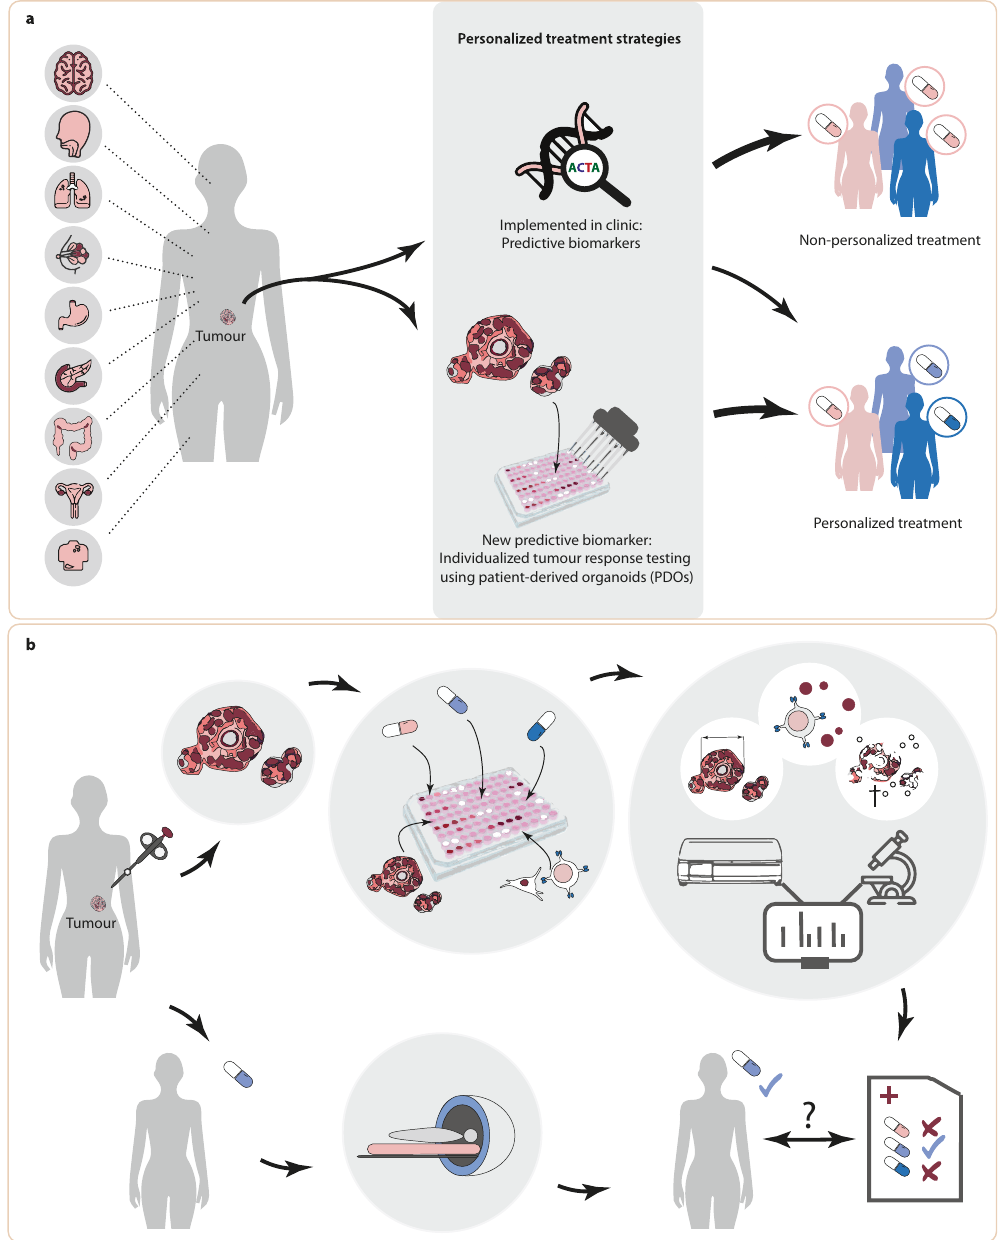
Fig. 1 PDO-based individualized tumour response testing as a predictive biomarker. a Illustrates the tumour types for which patient- derived organoids (PDOs) have been tested for clinical validity (listed in full in Table 1). Personalized treatment strategies currently implemented in oncology treatment largely comprise of genomic biomarkers. However, this only results in a personalized treatment strategy for a minority of patients. Individualized tumour response testing using PDOs is a new biomarker which may be used in personalized treatment and increases access to personalized treatment. b For individualized tumour response testing, tissue from a patient ’ s tumour is obtained to culture organoids, perform drug screens and various read-outs can be obtained to de fi ne PDO drug screen response (including organoid size, viability and co-culture cytokine measurements). A predictive biomarker test is developed using the PDO drug screen results and clinical response seen in assays and/or engraftment of organoids in mice (summarized in compositions and culturing techniques differ. Serum-free growth Supplementary Table 2). In four studies, genomic analysis factors are increasingly becoming available, which allows estab- included criteria for which PDOs could be excluded from analysis due to poor quality 14,21 – 23 . Of note, in several studies quality used serum-based media 17 – 19 , while one study did not specify control was performed on a subset of PDOs, not the whole cohort. A recent protocol for establishing PDOs for drug which medium was used to establish organoids 20 . All studies used screening suggests to perform genetic analysis of PDOs and the original tumour tissue to assess that the PDOs are representative